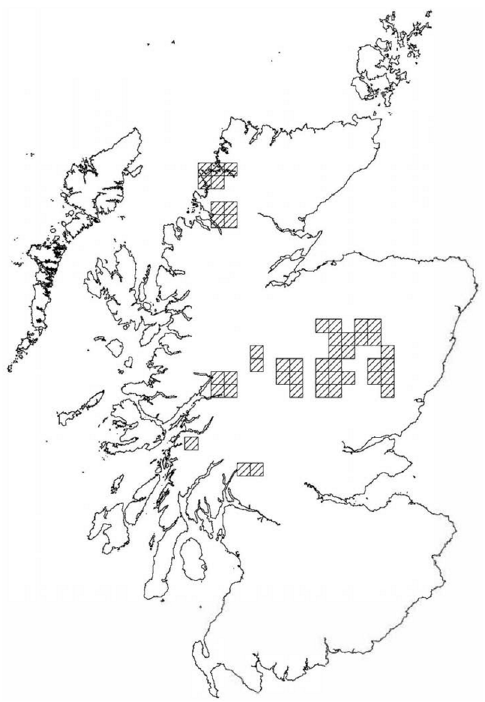
Fig 1. Map showing the 10 km blocks within which the study sites were